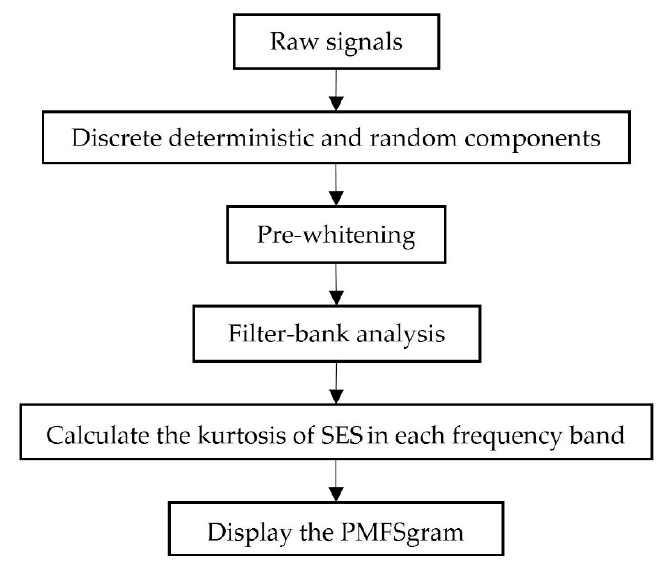
Figure 1. The flowchart of the new method.